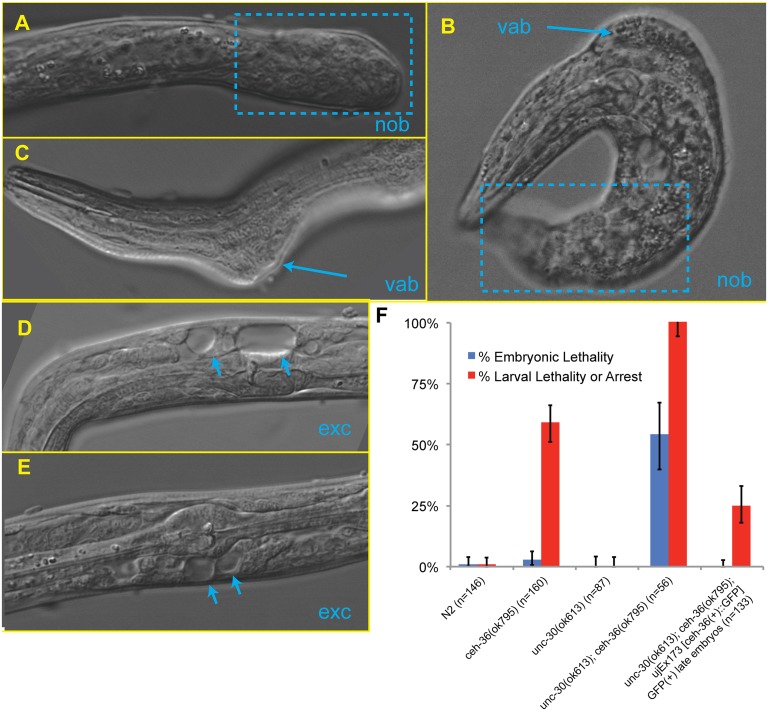
Examples of phenotypes in unc-30;ceh-36 double mutants.A, B) Failure of posterior morphogenesis resulting in a “no-backend” (Nob) phenotype (boxed). B, C) Variable abnormal defect (Vab) in body morphology (arrows). D-E) “Bubble” phenotypes characteristic of a blockage (Exc) in the excretory system (arrows). F) Embryonic and larval arrest rates for unc-30 and ceh-36 single and double mutants.